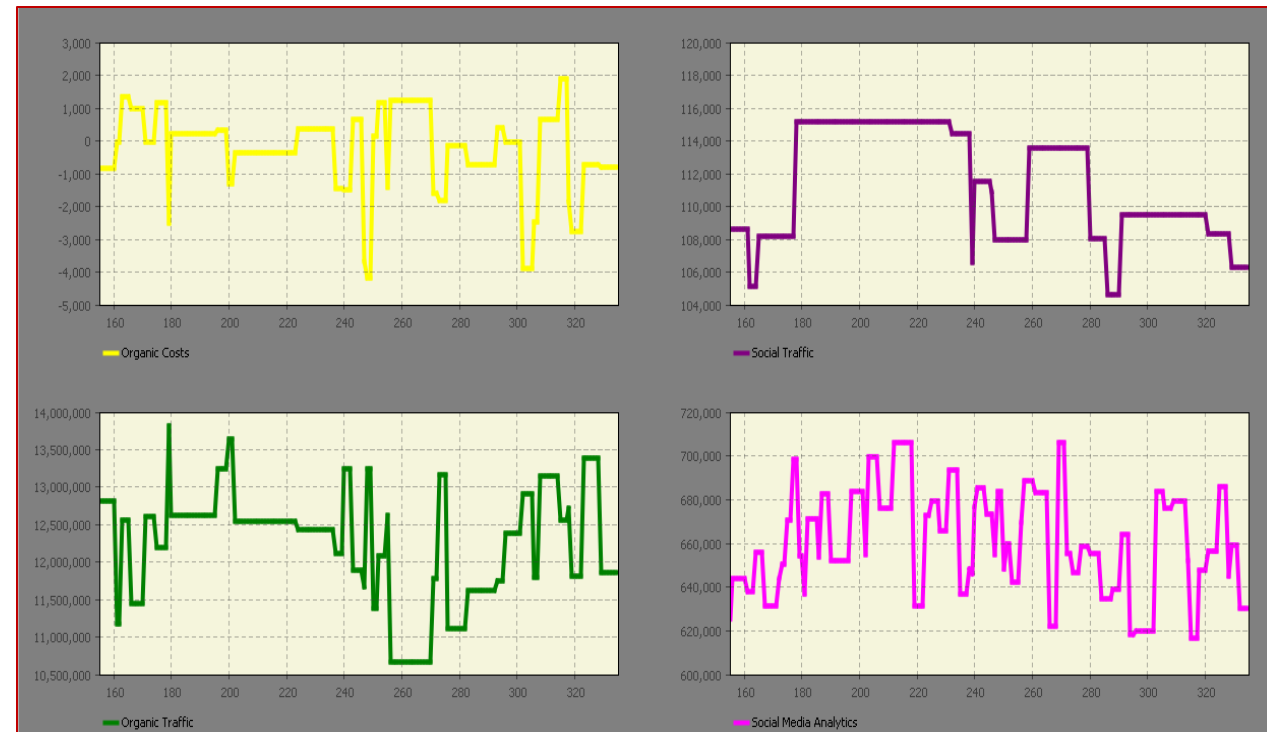
Figure 5. Population dispersion for 10,000 agents. ( a ) With little or no use of social media analytics and ( b ) with increasing usage of social media analytics.